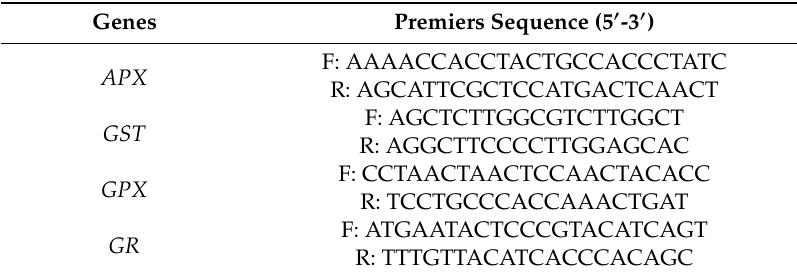
Table 5. DNA sequences of qRT-PCR primers for the determination of the ROS scavenging enzyme gene expression in wheat